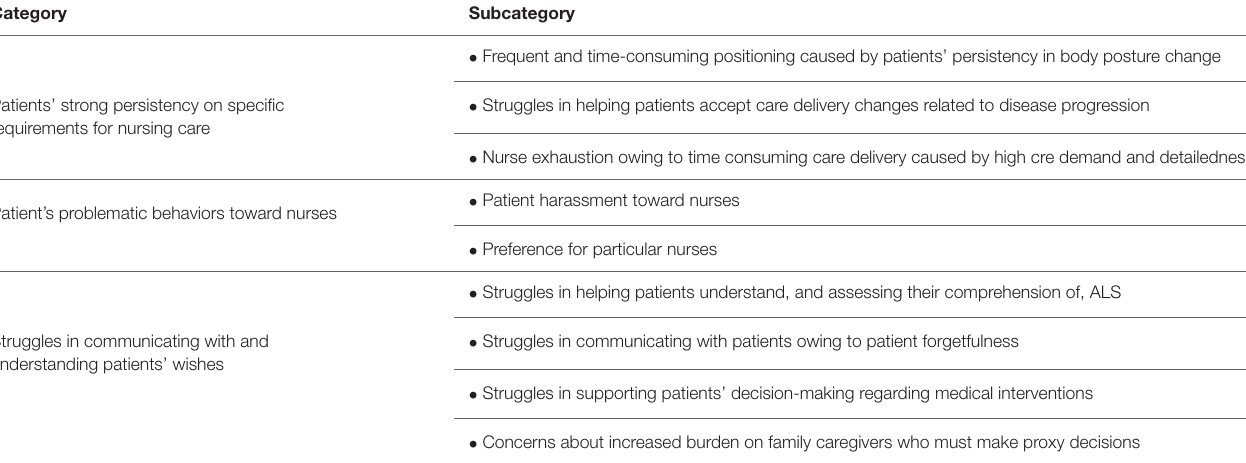
TABLE 1 | Situations with which nurses struggle in caring for people with ALS comorbid with cognitive impairment.